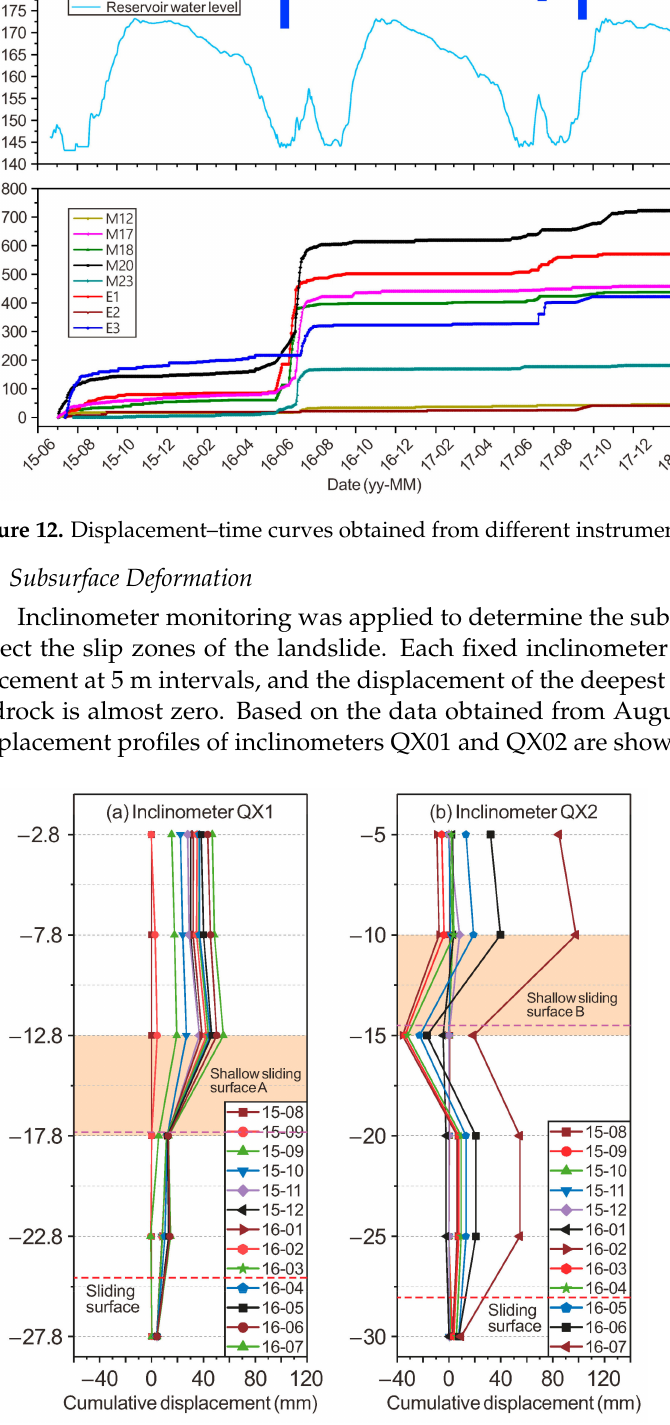
Figure 13. Subsurface displacements measured by the